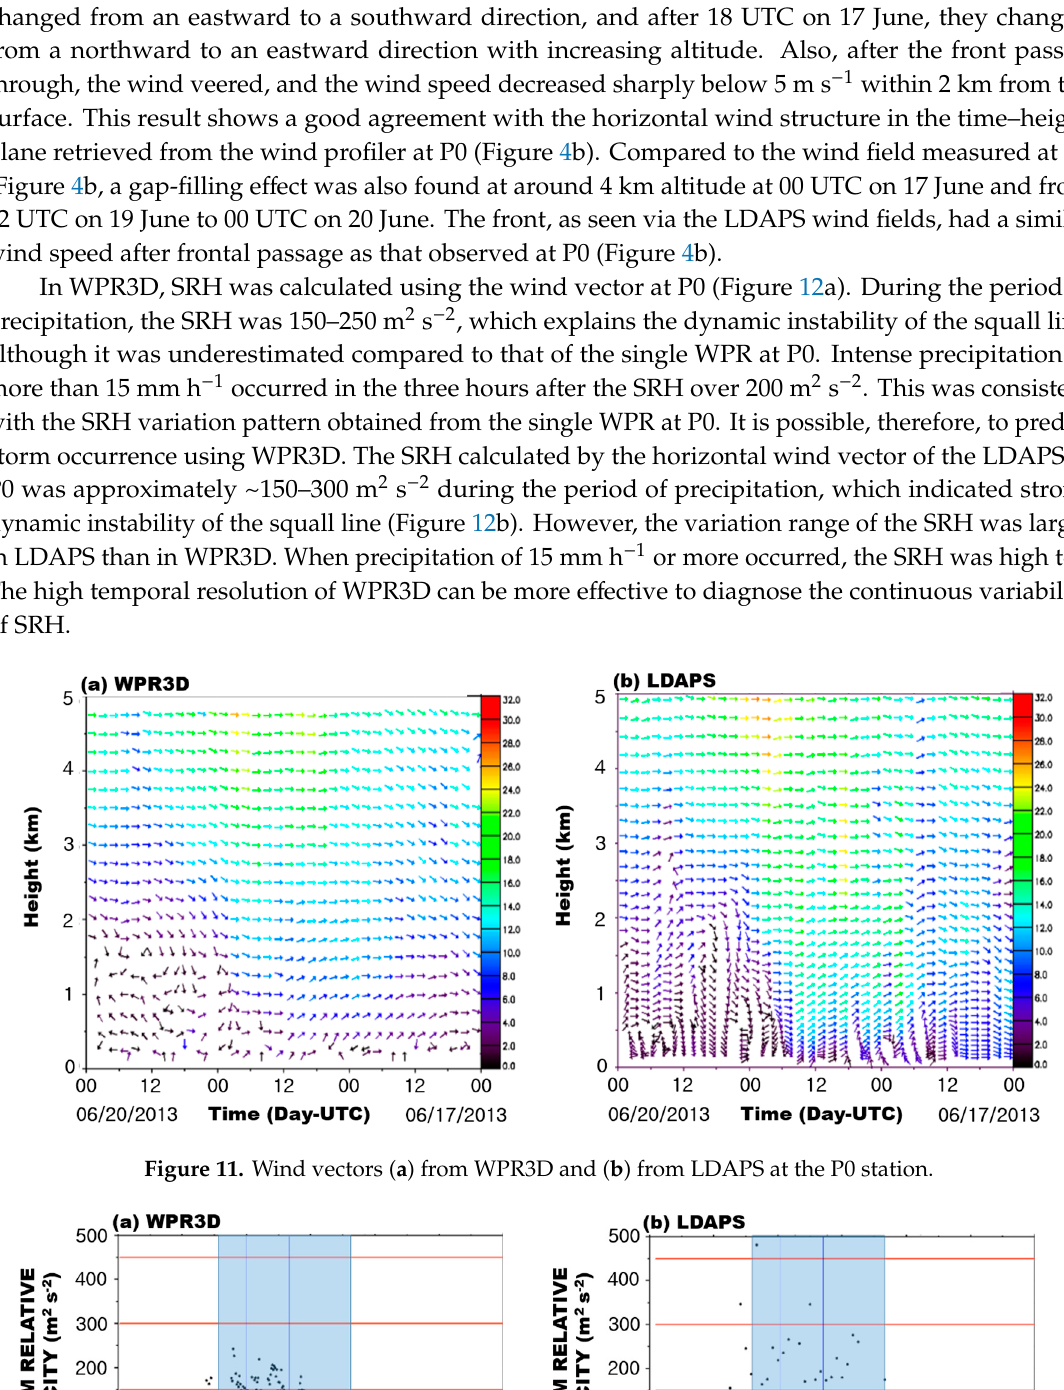
Figure 12. SRH ( a ) from WPR3D and ( b ) from LDAPS. The blue shading indicates the rainfall period with rainfall over 15 mm h − 1 with rainfall over 15 mm h − 1 .